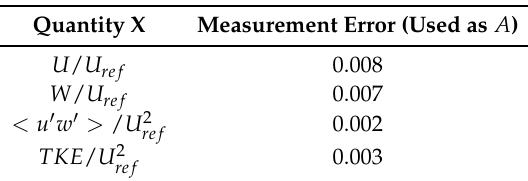
Table 2. Measurement error expressed as spatially-averaged standard deviation of the given dimensionless quantity (used as the Hit rate absolute deviation criterion A in Section 4.3.1).